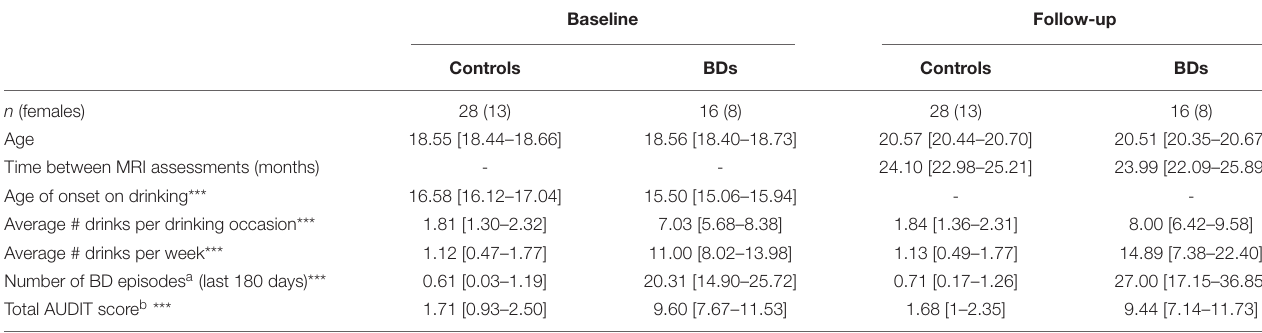
TABLE 2 | Demographic and alcohol use characteristics of the control and BD groups (mean [95%